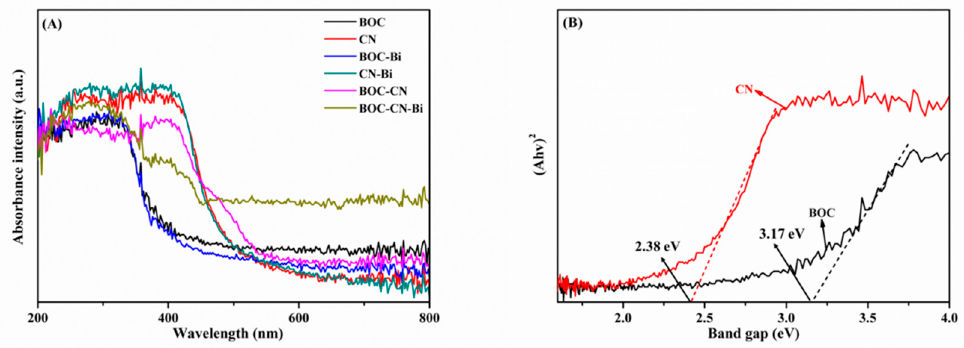
Figure 5. The DRS ( A ) of the as-obtained samples; the band gaps ( B ) of BOC and CN. In Figure 6A, the photocatalytic performance of all photocatalysts is evaluated via the photodegradation of the rhodamine B (RhB) under visible light ( ≥ 420 nm). Before the photoreaction process, all samples were kept in the dark to realize the adsorption-desorp- tion equilibrium. The value of RhB adsorption for all samples is shown in Table S2 (Sup- plementary Materials). Pristine BOC reveals an inconsequential photodegradation rate of 30% after 120 min because of its wide band gap. As for CN, only 50% of RhB is disinte- grated after 120 min. However, after the introduction of metal Bi, the binary BOC-Bi and CN-Bi exhibit better degradation rates (40% and 60%, respectively). Simultaneously, the photodegradation rate of the RhB for the BOC-CN compound is 45%. Interestingly, the ternary composites (BOC-CN-Bi) reveal the best photocatalytic activity compared to other samples, which is approximately 93% after 120 min. Additionally, the ternary BOC-CN- Bi heterojunction composites still possess high photocatalytic performance for RhB deg- radation compared to the reported BOC-CN photocatalysts. Therefore, we can reach the conclusion that metal Bi has a remarkable effect on enhancing photocatalytic performance. To explore the kinetic reaction, the kinetics of RhB degradation for all samples are ana- lyzed. The degradation data of all catalysts are linearly fitted according to the equation: Ln (cid:4672) (cid:2887) (cid:2887) (cid:3116) (cid:4673) (cid:3404) kt (cid:3397) a where C, C 0 and k are the concentration of RhB under the different times, the concentra- tion of RhB after the adsorption-desorption equilibrium, and the apparent reaction rate constant, respectively. As shown in Figure 6B, the relationship between Ln(C/C 0 ) and t of all samples conforms to the first-order kinetic model. The k of every sample is estimated and shown (Figure 6B). Obviously, BOC-CN-Bi possesses the fastest photodegradation rate, which is 6.2 and 3.5 times than that of BOC and CN. The aforementioned results forcefully verified that BOC-CN-Bi ternary composites possess a superior photocatalytic activity. We also explored the effects of pH, dye concentration and catalyst amount on photocatalytic degradation (Figure S2). Obviously, the more photocatalytic content, the better the degradation effect. However, the degradation efficiency and the catalyst in- crease disproportionately. Moreover, the concentration of organic pollutants increased, and the degradation efficiency decreased slightly. When pH increased, the degradation efficiency decreased significantly. When pH decreased, the catalyst completely adsorbed organic pollutants after darkness, and the degradation efficiency could not be measured (Figure S3, Supplementary Materials). It is well known that the stability of photocatalysts is crucial in practical applications. Therefore, the cycling experiments of BOC-CN-Bi com- posites were carried out. As shown in Figure 6C, the photocatalytic performance is not significantly reduced in three cycles, which confirms the outstanding stability of the com- posites.